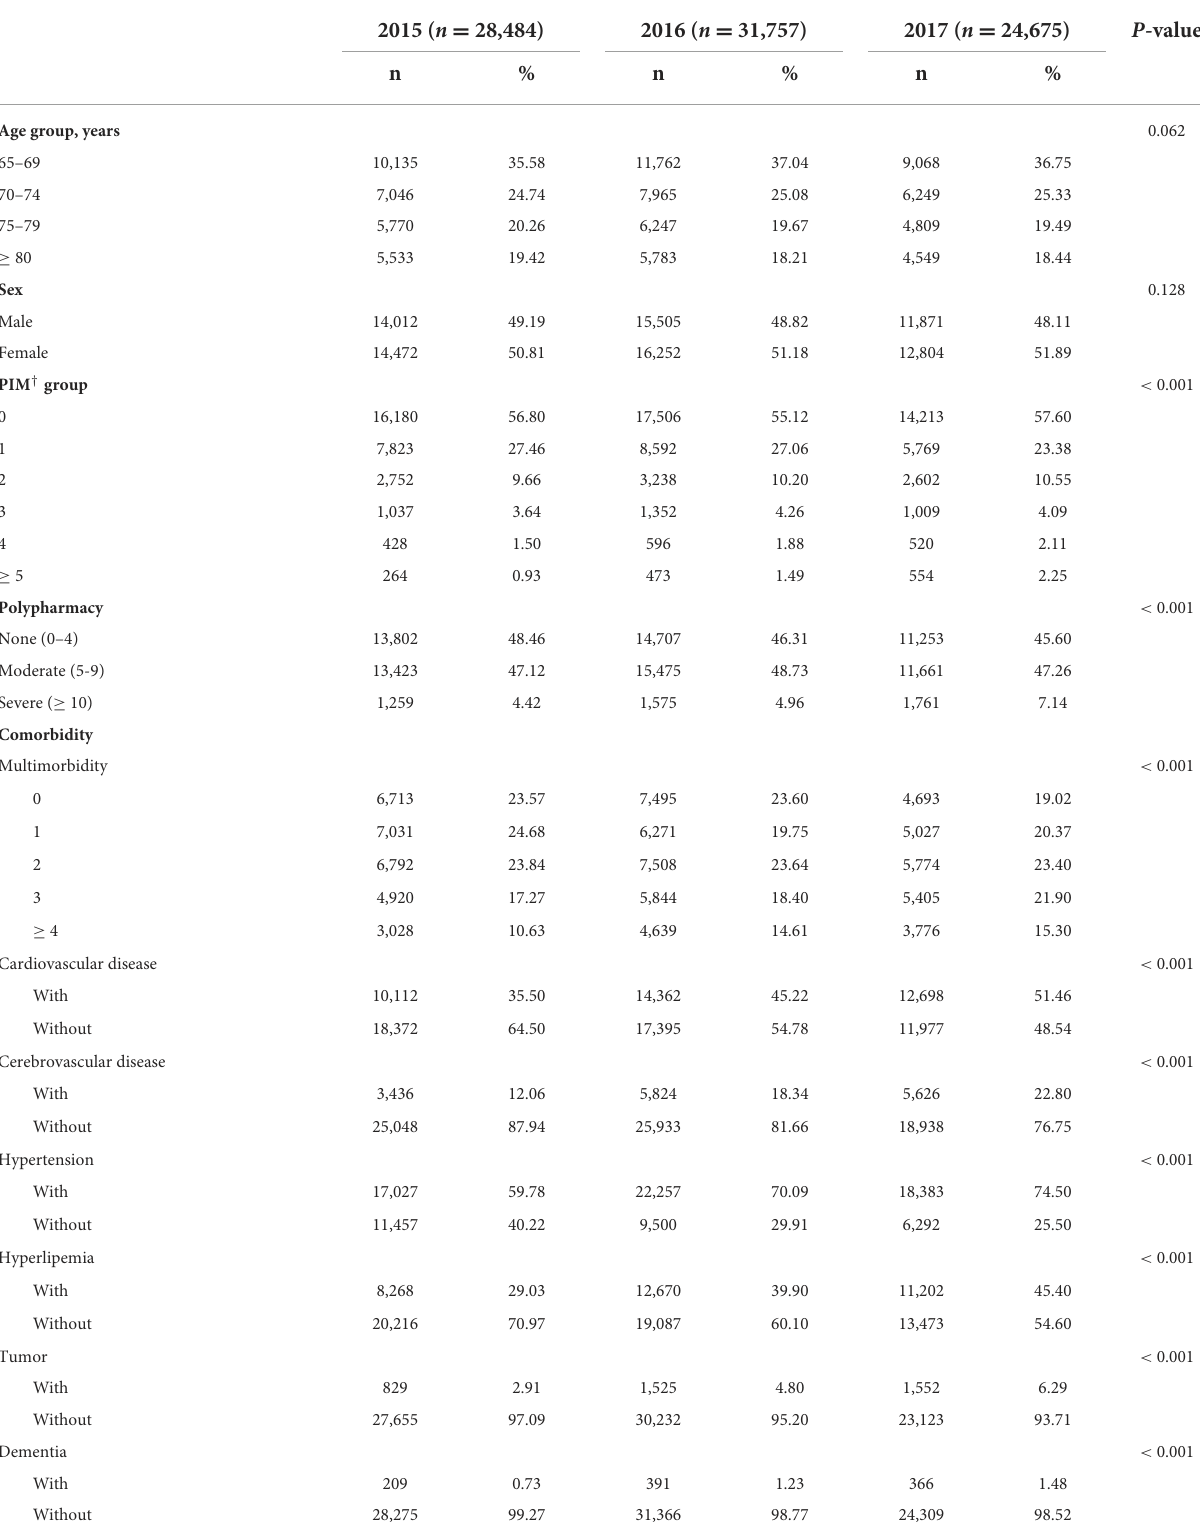
TABLE 1 Baseline characteristics of older adults with diabetes in 2015, 2016, and